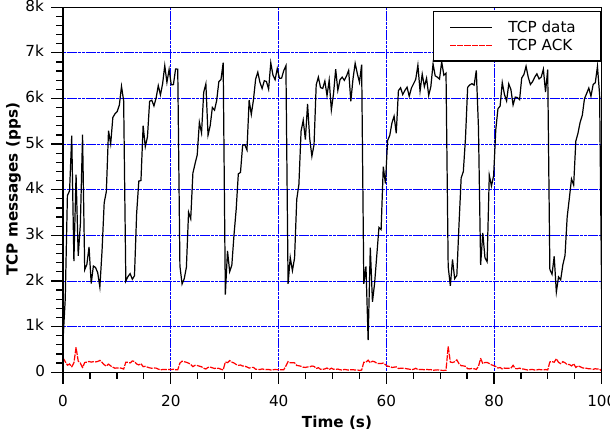
Figure 11. TCP session throughput on router with an unmodified Linux kernel.